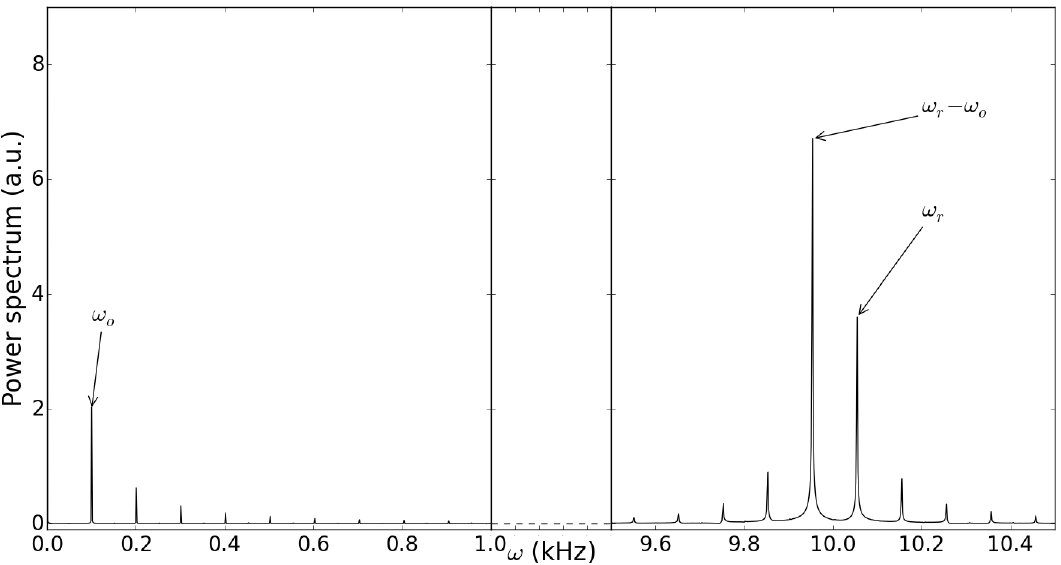
Figure 4. Fourier transform of ∆ N ( t ) represented in Figure